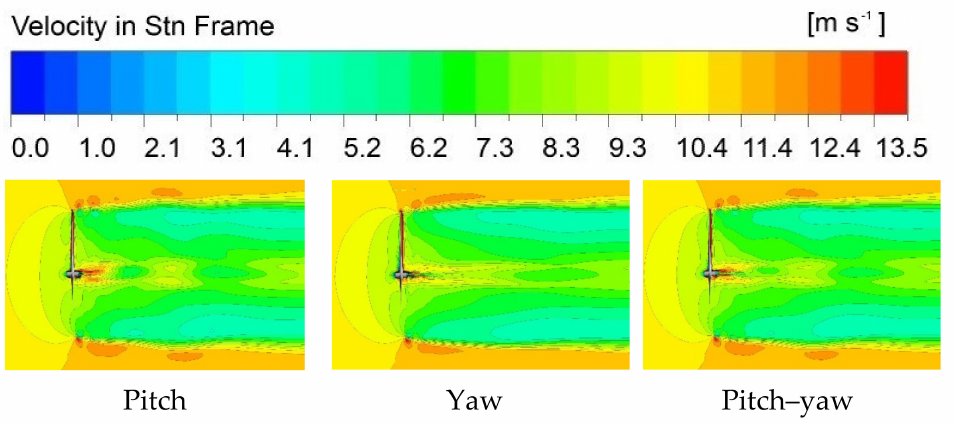
Figure 16. Velocity distribution at Position 1.